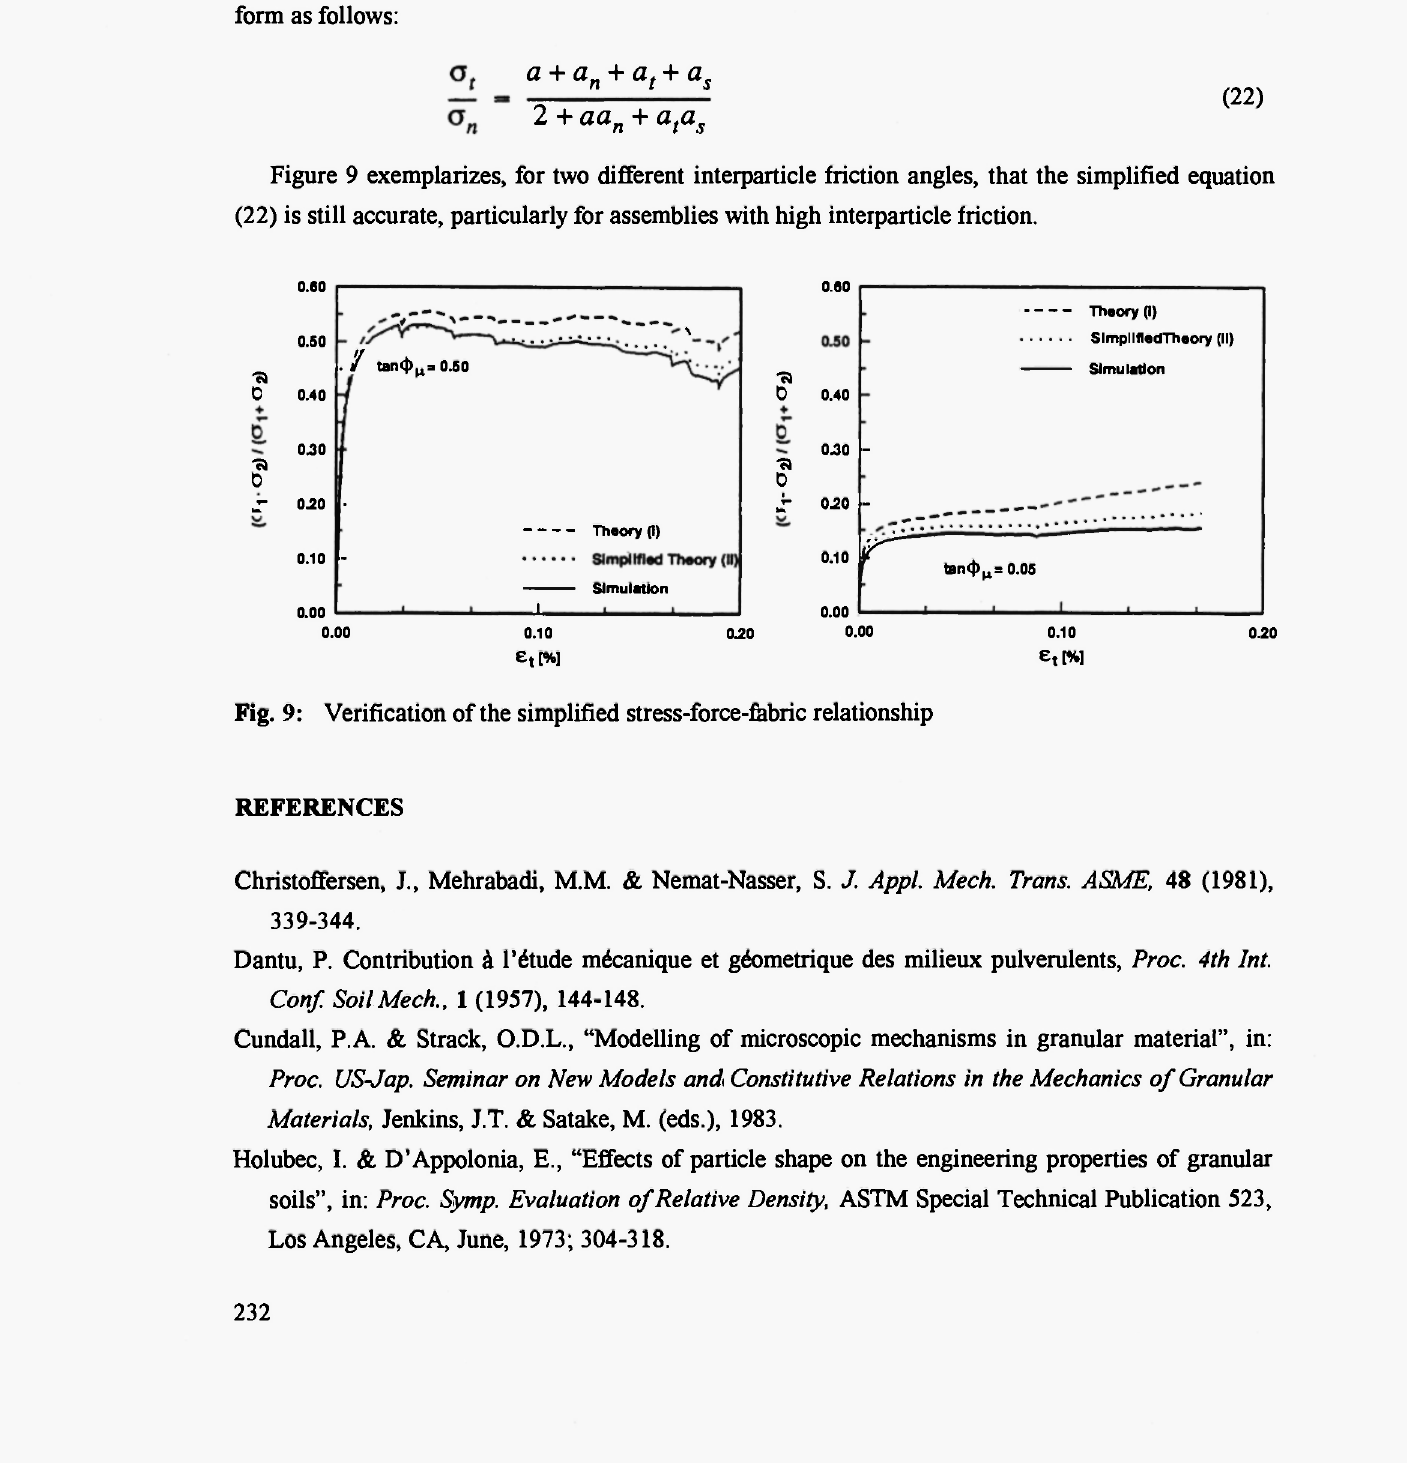
Fig. 9: Verification of the simplified stress-force-fabric